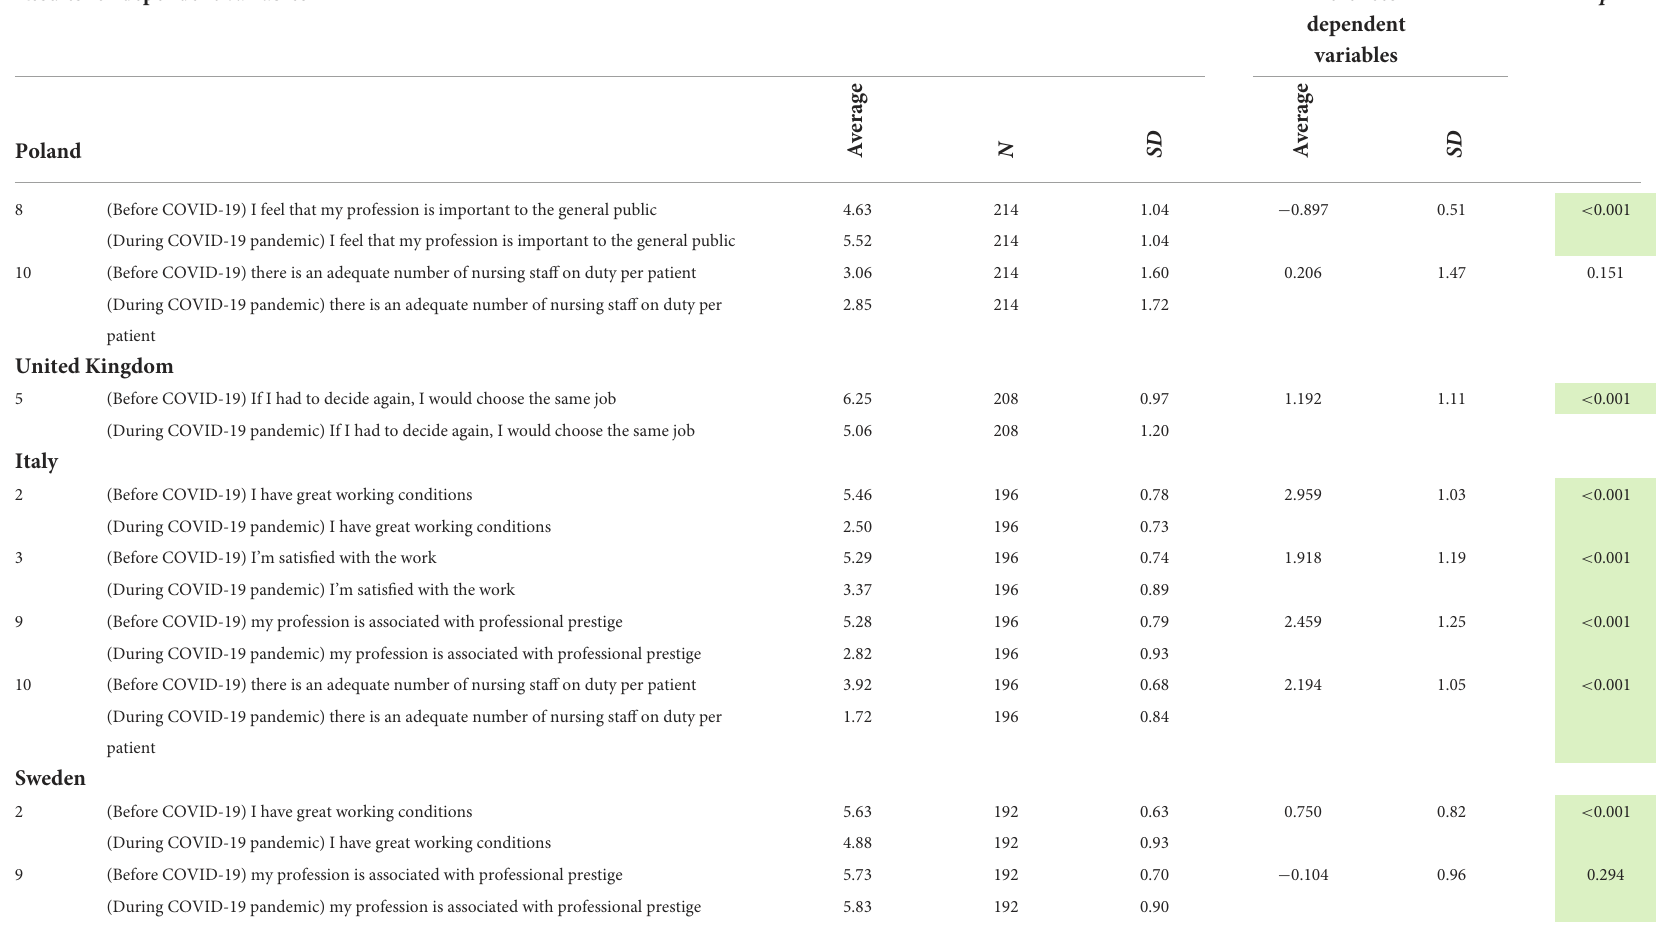
TABLE 3 Impact of the pandemic on professional job satisfaction among the nursing staff in the surveyed European countries. Results for dependent variables Differences in